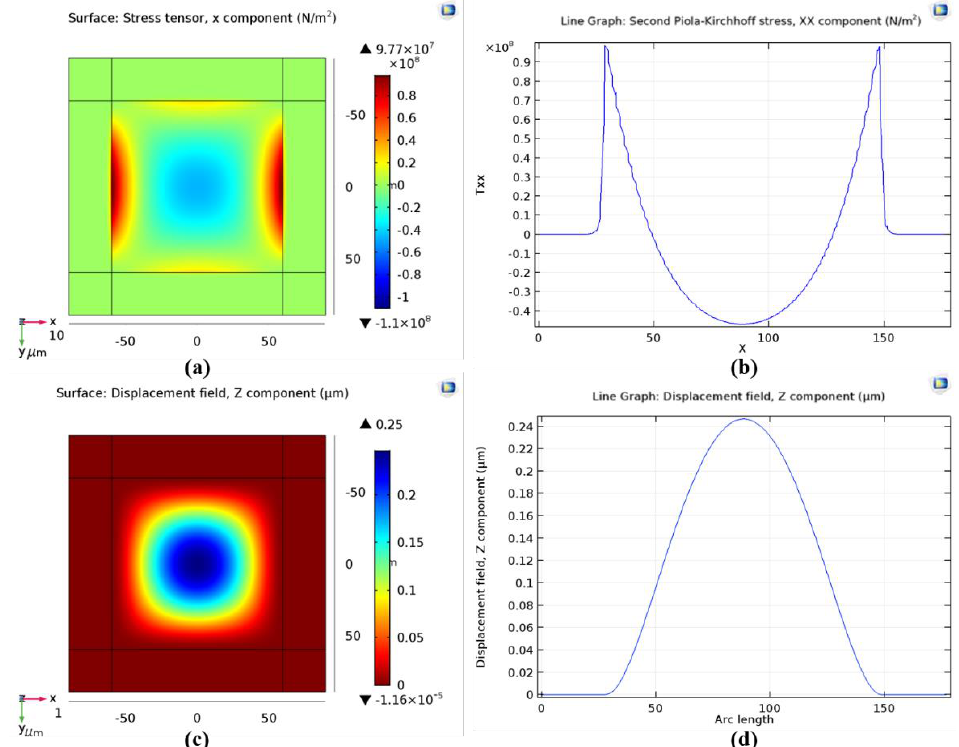
Figure 3. COMSOL simulation results of tactile sensor. ( a ) Stress simulation of the silicon nitride diaphragm; ( b ) Stress simulation result shows that the maximum stress occurs at the edge of the silicon nitride diaphragm, and its value is 98.59 MPa; ( c ) Displacement simulation of the silicon nitride diaphragm; ( d ) Displacement simulation result shows that the maximum displacement occurs at the center of the silicon nitride diaphragm, and its value is 0.25 μm.